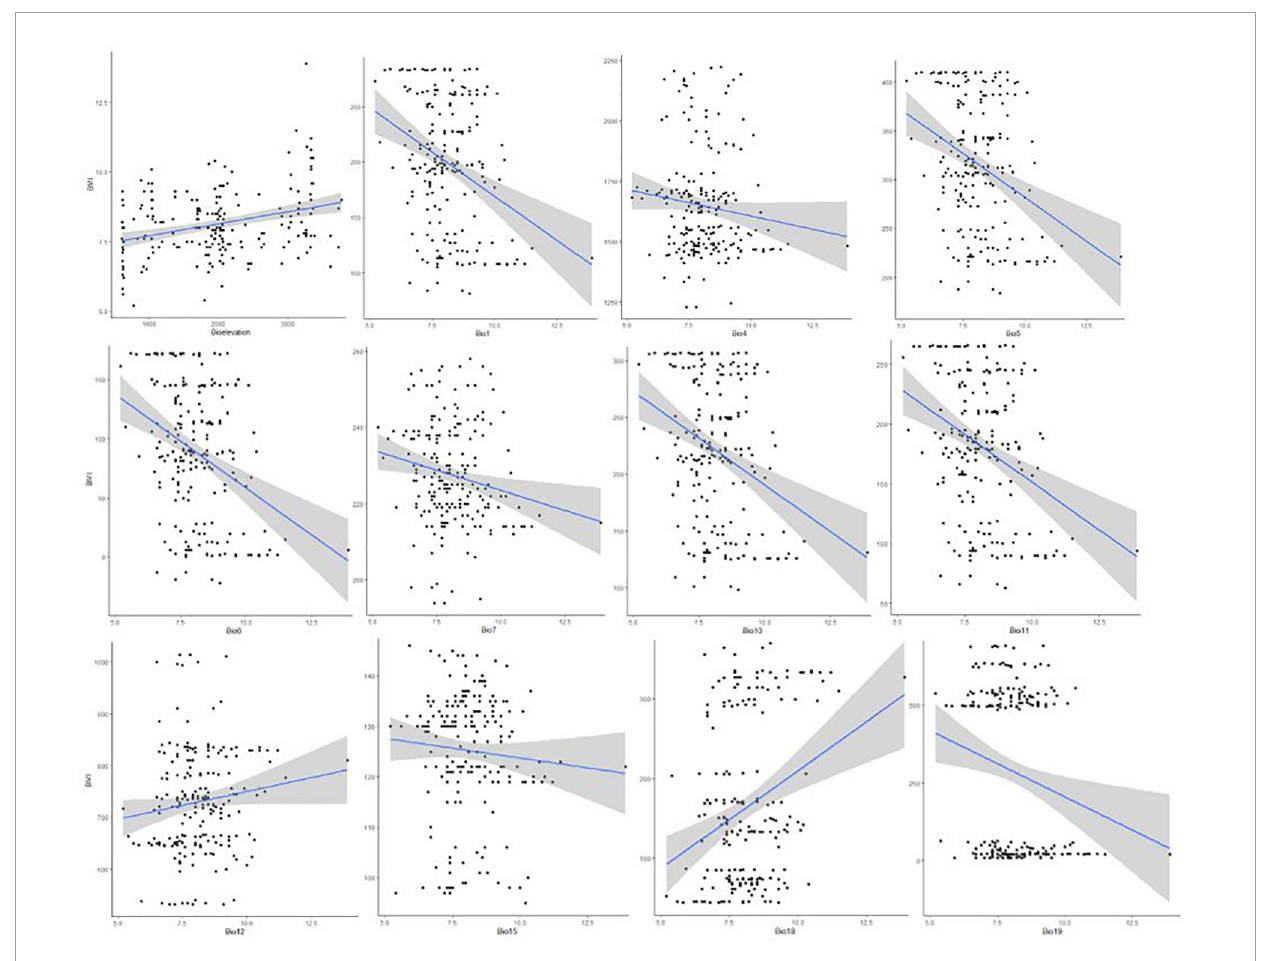
FIGURE6 Correlation between environmental variables and chicken morphology (BMI) to validate Bergmann’s